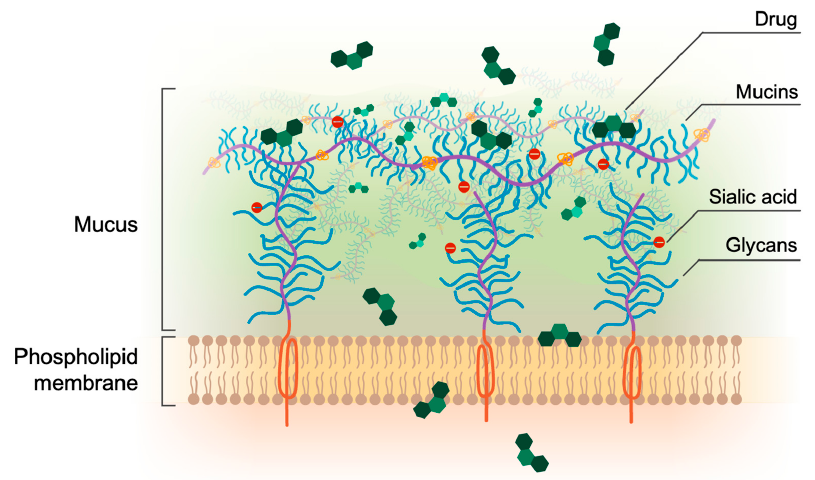
Figure 1. The mucosal barrier. Drugs administered by the oral, inhalation, or vaginal routes must cross the mucus layer and the cellular membrane in order to be absorbed. Due to its complex structure and chemical diversity, mucus can interact with drugs via different mechanisms and selectively filter their permeation. In this paper, we adopt a new, cell-free, high-throughput permeability model called PermeaPad to construct an in vitro mucosal platform. The recently introduced PermeaPad 96-well plate has been presented as a promising new tool for rapid-permeability profiling [22]. However, the physicochemical determinants governing its permeation mechanisms are still unclear. The main aims of this work are: (a) to selection a chemically heterogene- ous dataset; (b) complete the permeability profiling of the dataset and identify the physi- cochemical properties ruling the permeation flux; and (c) to couple the PermeaPad 96- well plate with a cystic fibrosis mucus model and assess the impact of mucus on permea- tion. Overall, this paper expects to provide insights into PermeaPad permeability mecha- nisms. Moreover, by setting up a new mucosal platform, we expect to provide medicinal chemists with a new tool that is useful for predicting mucosal permeability. 2. Experimental Section 2.1. Structures and Molecular Descriptors DrugBank was used to obtain the drug simplified molecular-input line entry system (SMILES) codes [23]. DataWarrior (version 5.5.0, openmolecules.org/datawarrior), MarvinSketch (ChemAxon, ver. 22.19, www.chemaxon.com), and ADMETLab 2.0 (ad- metmesh.scbdd.com/) [24] were used to compute a set of 78 molecular descriptors. Com- puted descriptors include physicochemical descriptors, drug-likeness-related characteris- tics, multiple atom and ring counts, flexibility, surface area, and functional groups. Some additional descriptors were also calculated. The molecular charge and distribution coeffi- cient at pH 7.4 were retrieved using MarvinSketch. Three-dimensional structures were obtained using Corina Demo (Molecular Networks GmbH and Altmira, LLC) and used to compute 3D-related molecular descriptors. Table S1 reports the list of all the molecular descriptors considered. The correlation matrices were computed in DataWarrior. 2.2. Materials